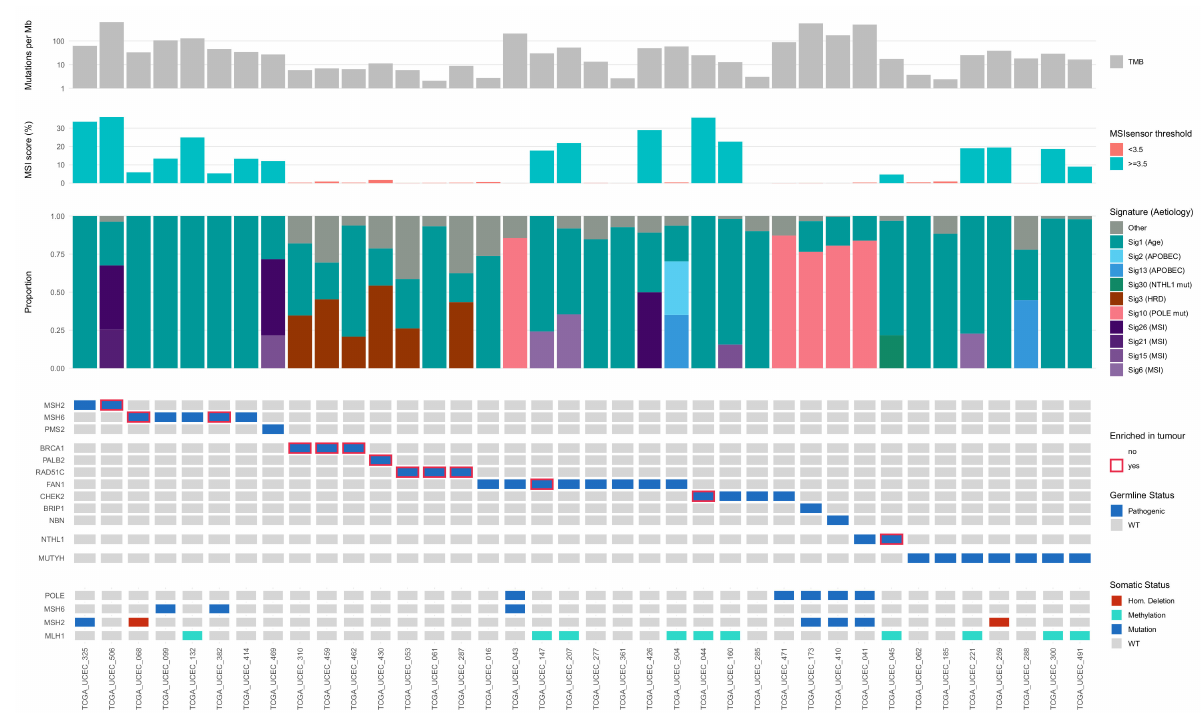
Figure 1. Somatic mutational signature analysis of the germline variant carriers in the TCGA-UCEC cohort. Tumor mutation burden (TMB), microsatellite instability (MSI) scores and mutational signatures observed in the TCGA-UCEC cases with pathogenic or likely pathogenic variants in DNA damage repair genes associated with specific mutational